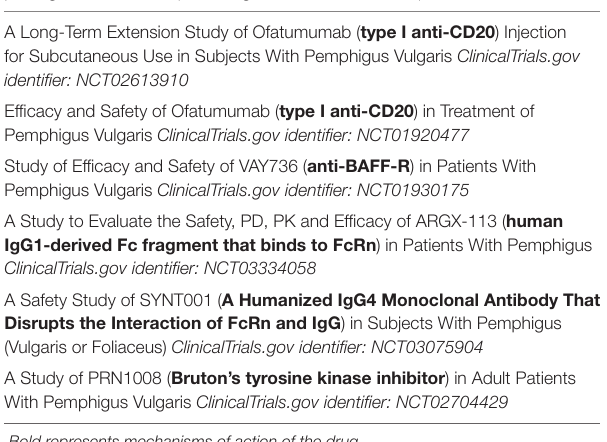
TABle 1 | Current ongoing studies in pemphigus that target B cells or their pathogenic antibodies (excluding studies with rituximab). A Long-Term Extension Study of Ofatumumab ( type i anti-CD20 ) Injection for Subcutaneous Use in Subjects With Pemphigus Vulgaris ClinicalTrials.gov identifier: NCT02613910 Efficacy and Safety of Ofatumumab ( type i anti-CD20 ) in Treatment of Pemphigus Vulgaris ClinicalTrials.gov identifier: